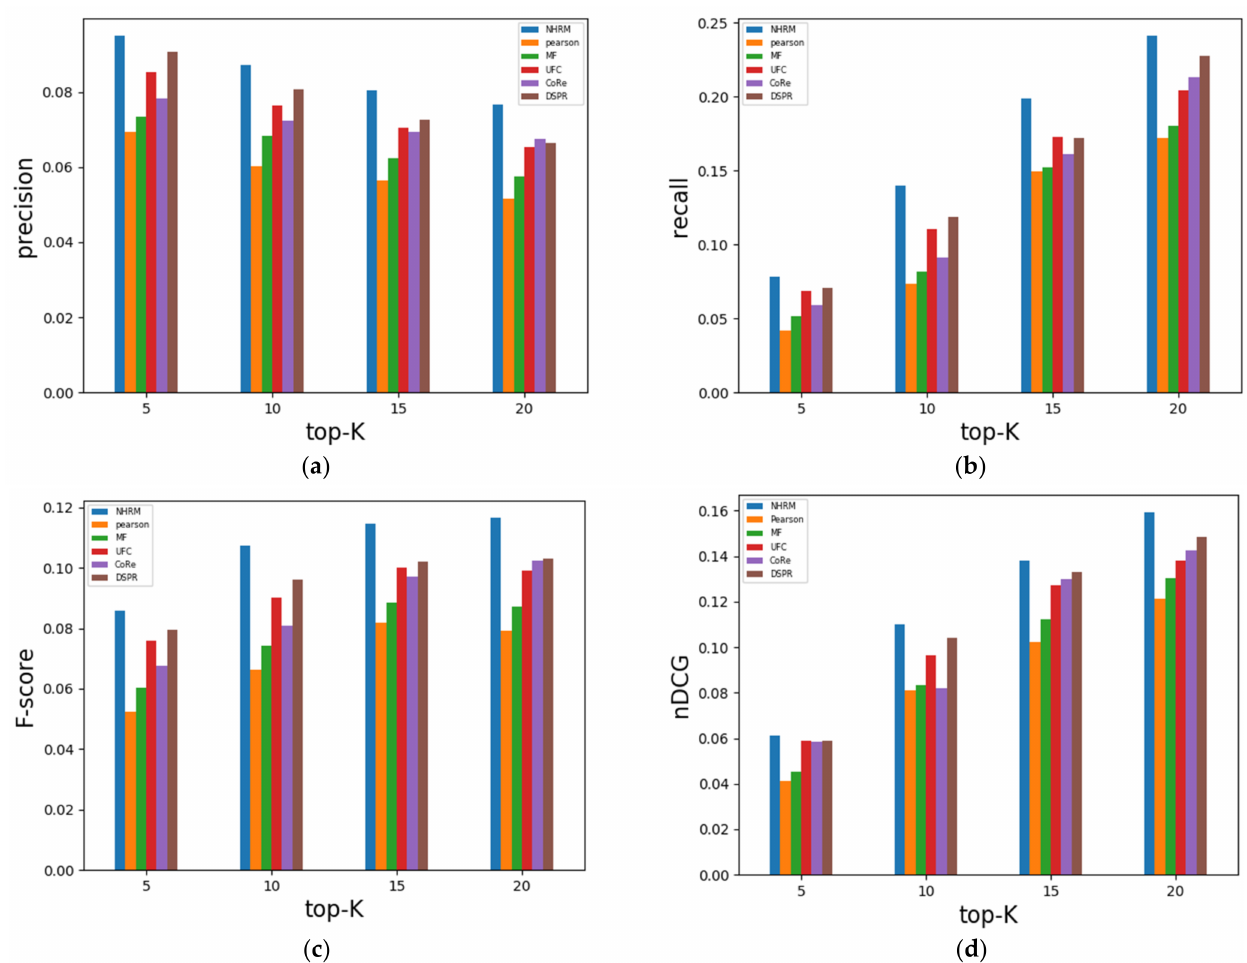
Figure 4. Comparison of results on Meituan data set. ( a ) comparison of Precision of each method on Meituan data set. ( b ) comparison of Recall of each method on Meituan data set. ( c ) comparison of F-score of each method on Meituan data set. ( d ) comparison of nDCG of each method on Meituan data